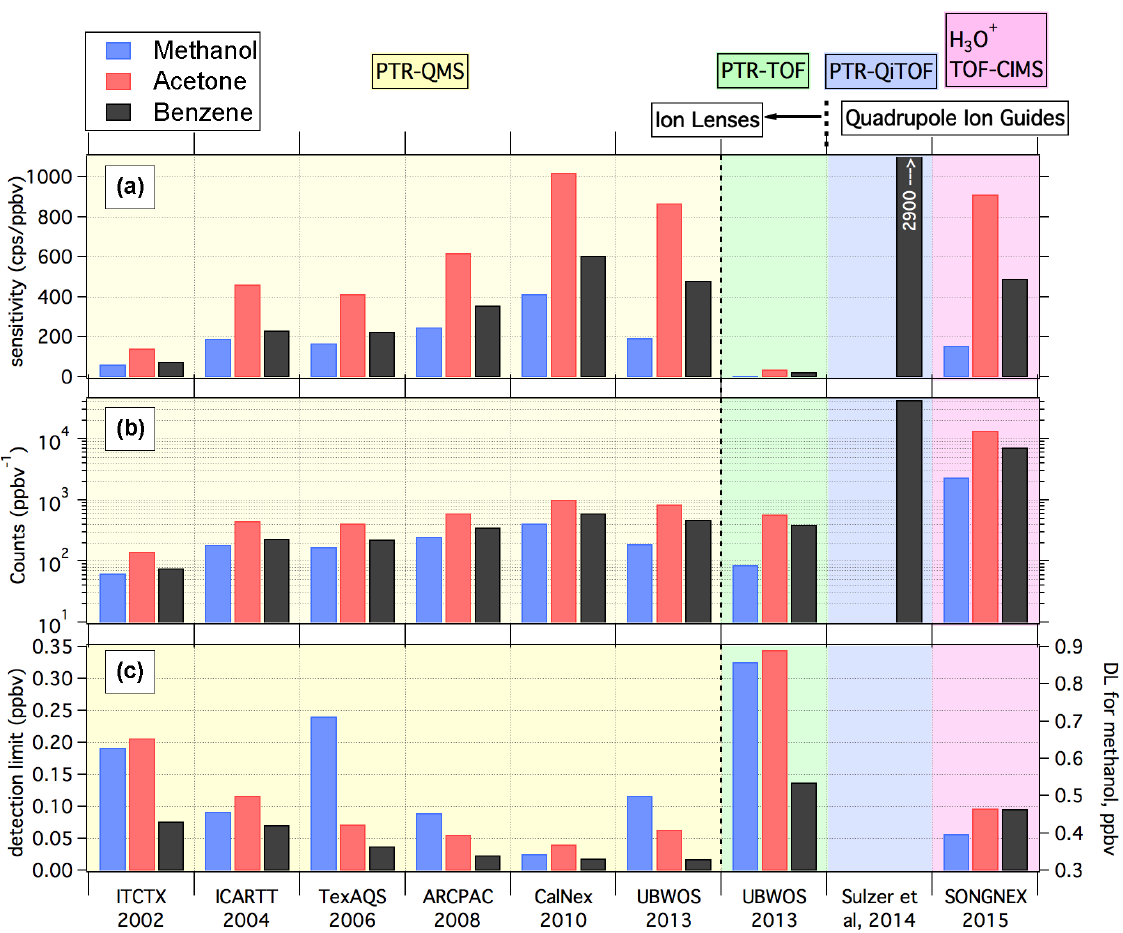
Figure 10. Comparison of the sensitivities (a) , total ion counts from measurements in a period of 15s (b) and 1s detection limits (c) of methanol, acetone and benzene for the NOAA PTR-QMS (Warneke et al., 2011), a PTR-ToF during UBWOS 2013 (Warneke et al., 2015), the PTR-QiToF in Sulzer et al. (2014) and the H 3 O + ToF-CIMS presented here during SONGNEX. In (b) , we assume that the PTR-QMS was operated at the typical cycle length of 15s with 1s dwell time for the three compounds as have been the norm during our aircraft measurements. Note that the detection limits (DL) of methanol in (c) are drawn on the right